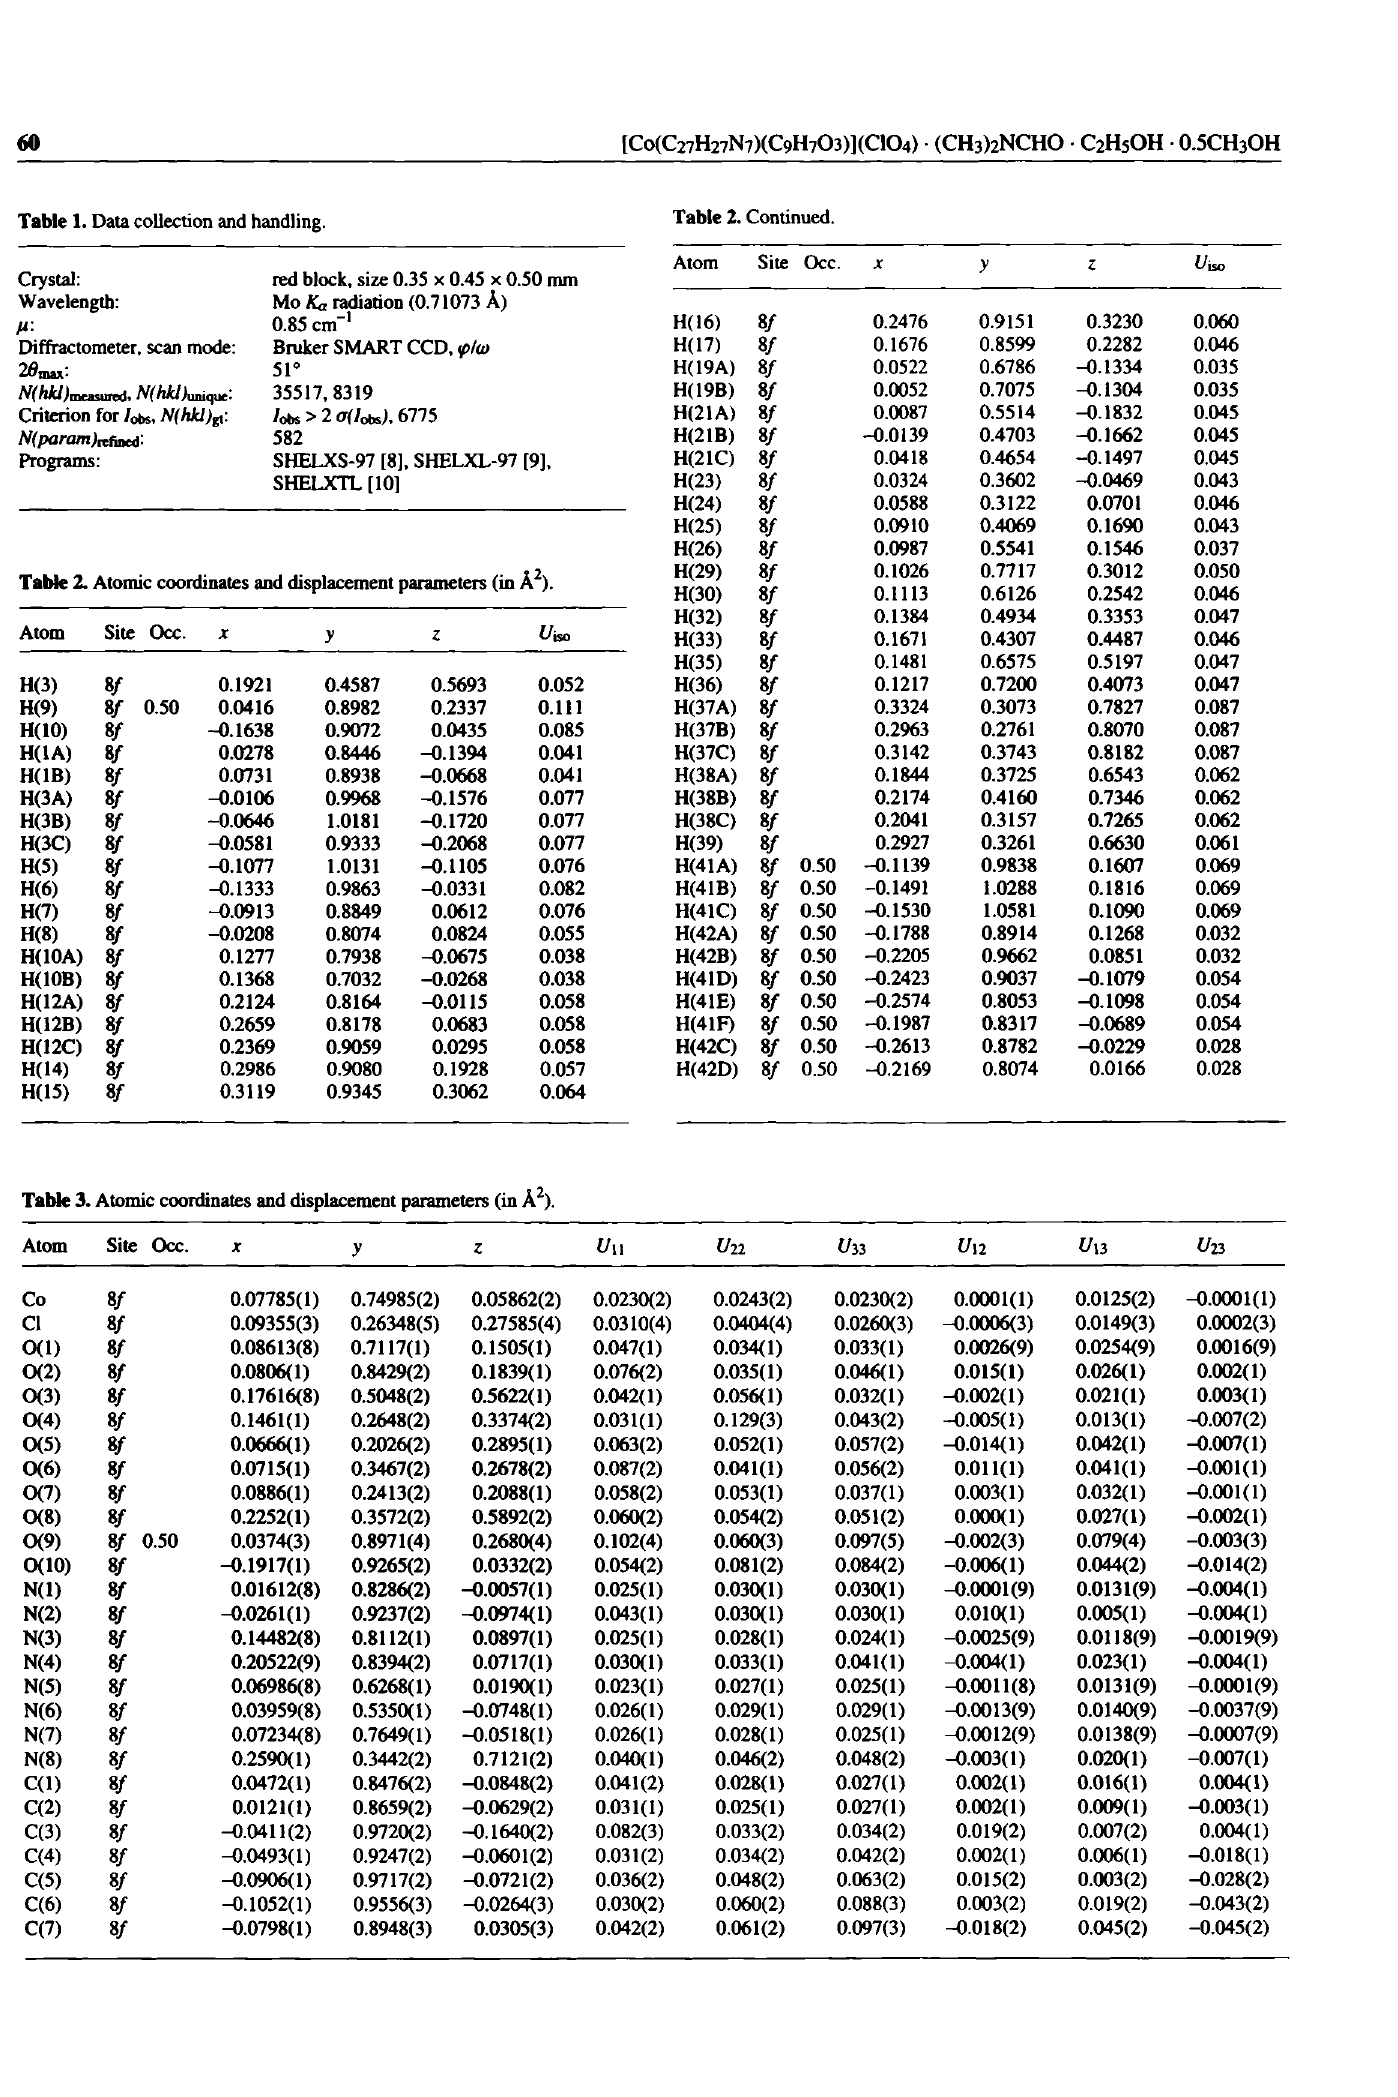
Table 2. Atomic coordinates and displacement parameters (in Â 2 ).